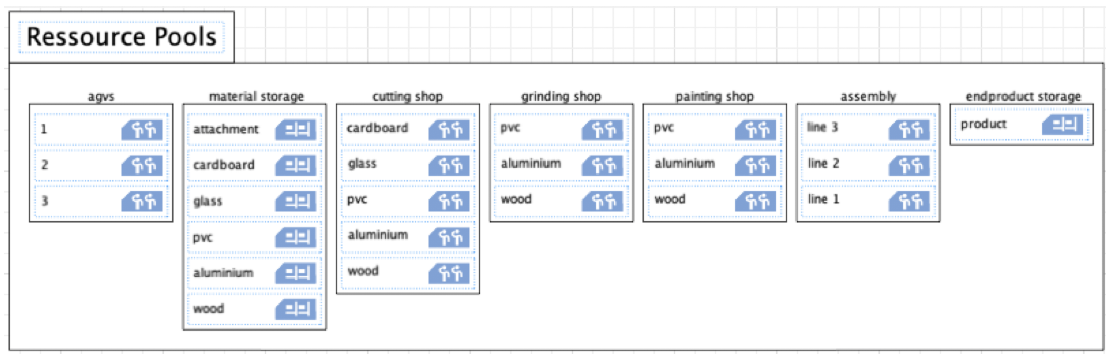
Figure 3. Defined resource pools for shop floor, Software [10].